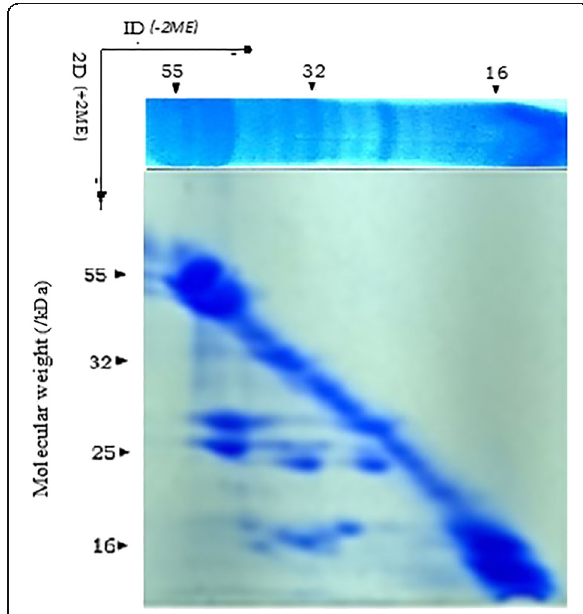
Fig. 2 Two-dimensional gel electrophoresis of total seed protein extracts of cotton line ‘ F-2228 ’ .ID ( − 2ME): SDS-PAGE under non- reducing conditions in first dimension; 2D (+2ME): SDS-PAGE under reducing conditions in the second